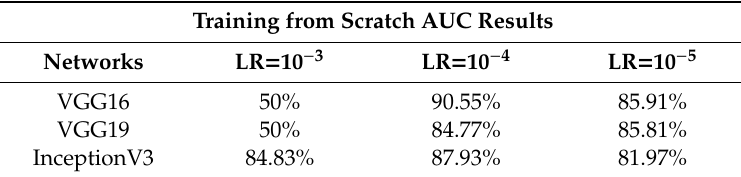
Table 5. Results of di ff erent architectures trained from